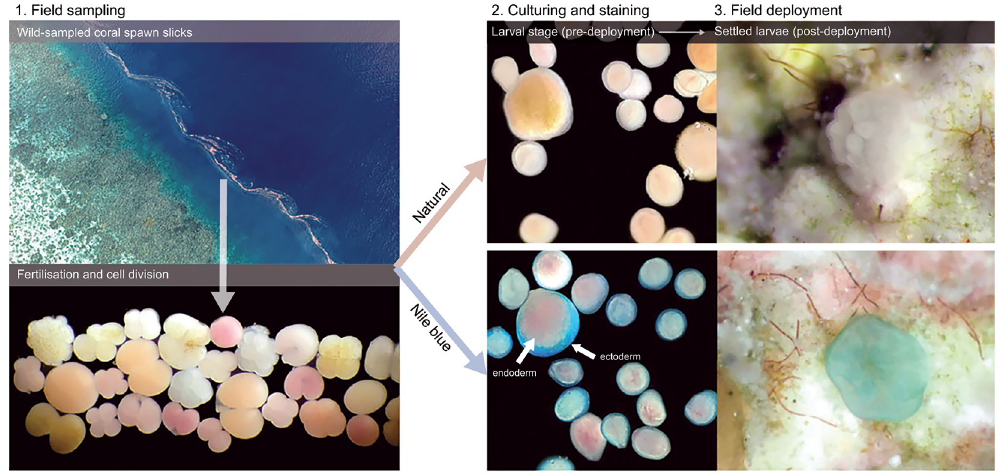
Fig 5. Field validation of larval staining: capture of wild-sampled coral spawn slicks showing high diversity of developing coral embryos, lab-based staining using Nile blue (1,000 mg l − 1 concentration for 60 minutes), and field deployment of competent stained and natural (unstained) larvae for detection on reef substrates. Images supplied by